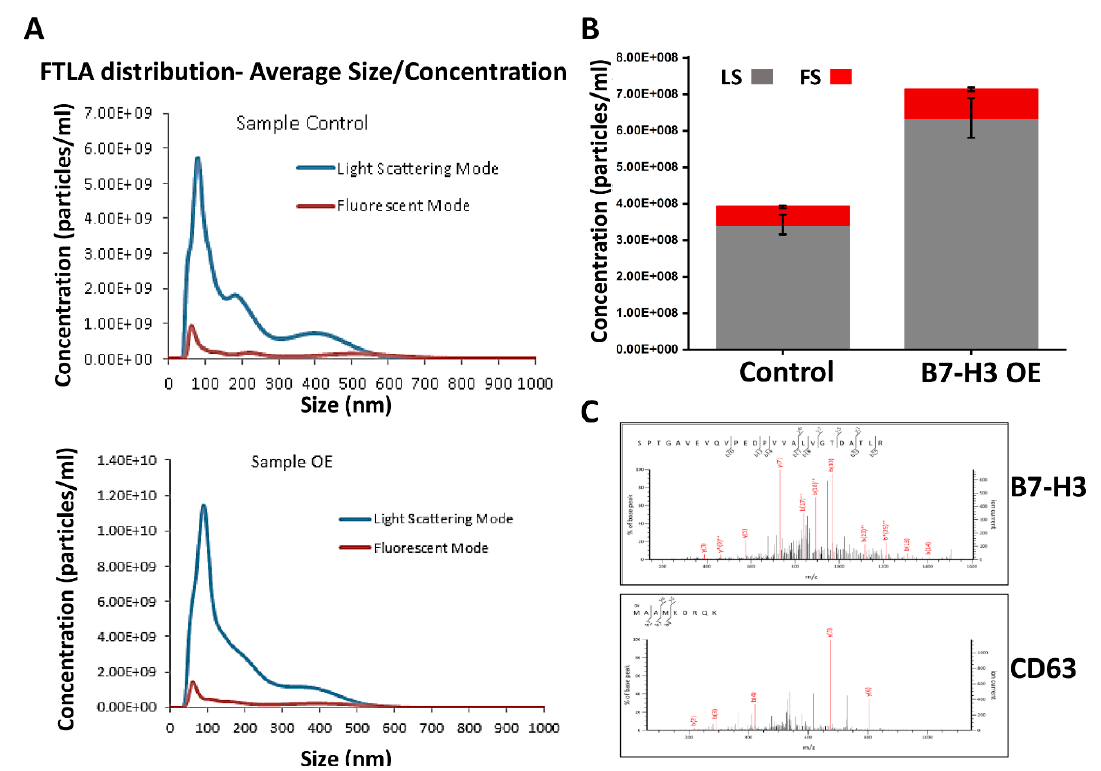
Figure 1. B7-H3 increases exosome secretion in medulloblastoma (MB) cells: ( A ) graphs from fluorescent NTA (SBI) showing increased size distribution of exosomes between control and B7-H3 overexpressing (B7-H3 OE) D283 cells. ( B ) Bar graph showing increased absolute concentration of exosomes in B7-H3 OE conditioned media compared to control cells. Error bars shown for light scattering mode and fluorescent mode. ( C ) LC-MS/MS analysis showing the presence of B7-H3 and CD63 peptide peaks in exosomes isolated from D283 cells.